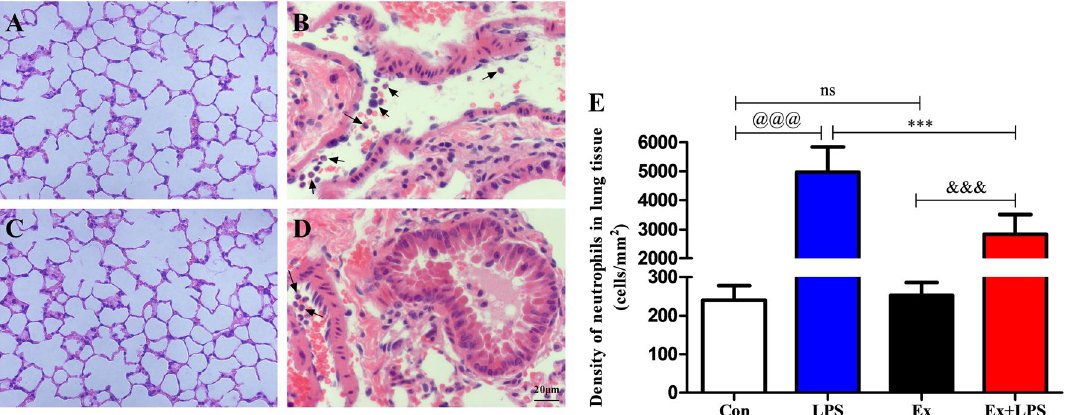
Figure 3. The density of neutrophils in lung tissue. ( A ) Con group, ( B ) LPS group, ( C ) Ex group, ( D ) Ex + LPS group, ( E ) detection of the density of neutrophils in lung tissue. Black arrows indicate neutrophils. @ P < 0.05, Con versus LPS groups; * P < 0.05, LPS versus Ex + LPS groups; & P < 0.05, Ex versus Ex + LPS groups [( A – D ) × 100 magnification].